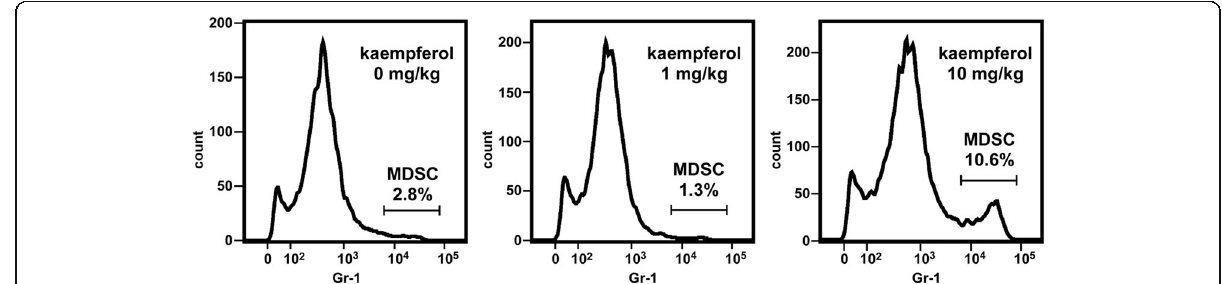
Fig. 7 Effects of kaempferol on the number of MDSCs in epididymal adipose tissue of mice. Kaempferol (1 or 10 mg/kg, twice weekly) or vehicle was intraperitoneally injected to lean C57BL/6 mice for two months. The vascular stromal fraction was stained, and subsequently subjected to FACS analysis. Representative FACS images of CD11b + cells in triplicates are shown. Proportion of CD11b + , Gr-1 + MDSCs in all CD11b + cells and doses of kaempferol are also